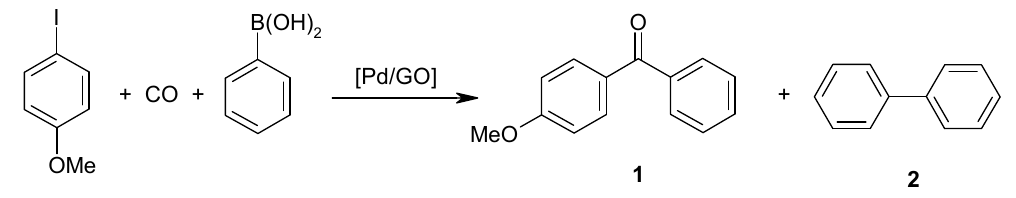
Figure 4. The carbonylative Suzuki-Miyaura reaction.